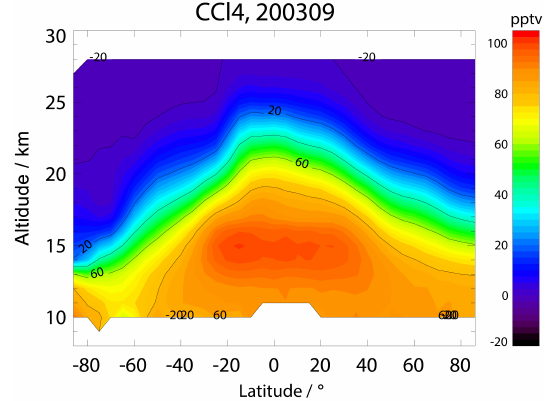
Figure 7. Altitude–latitude cross sections of MIPAS CCl 4 for the FR period (September